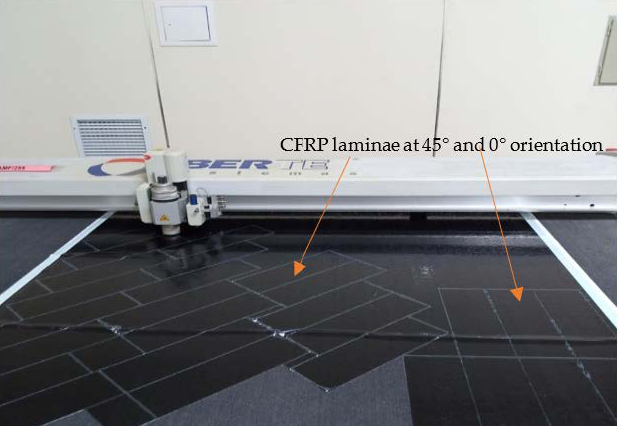
Figure 2. CFRP laminae at 45 ◦ and 0 ◦ orientation on Zund 1600 cutting plotter.